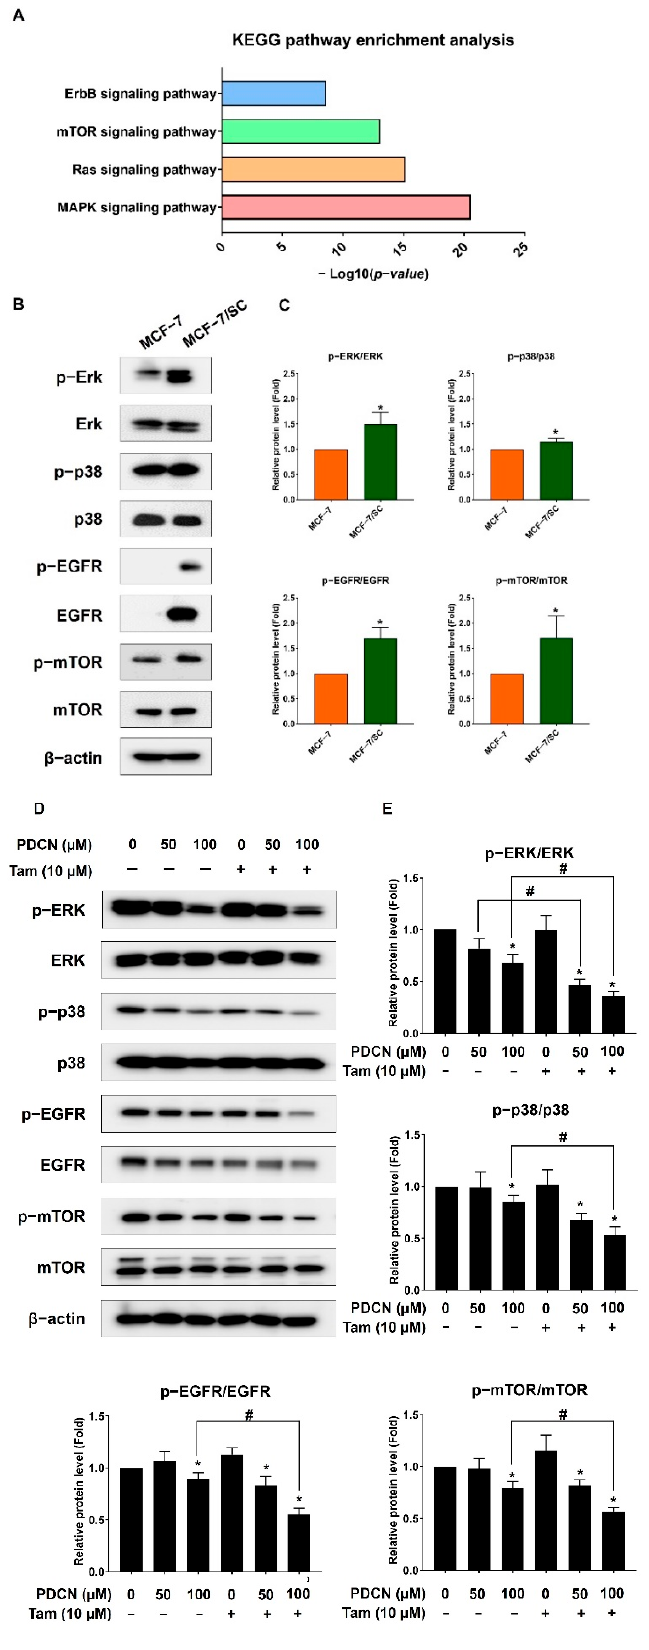
Figure 8. Pentadecanoic acid combined with tamoxifen inhibited survival − associated signaling pathways. ( A ) KEGG analysis was used to analyze the enrichment of common survival pathways in MCF − 7/SC cells compared to those in MCF − 7 cells. The levels of proteins related to ERK1/2, MAPK, EGFR, and mTOR signaling compared between MCF − 7 and MCF − 7/SC ( B , C ) cells or fol- lowing pentadecanoic acid or combined treatment for 48 h in MCF − 7/SC cells ( D,E ). β− actin was used as a loading control. The asterisk (*) indicates p < 0.05 vs. the control. The hash mark (#) indi- cates p < 0.05 when comparing the combined vs. individual treatments. Data are representative of three biologically independent experiments and values are shown in mean ± SD. 3. Discussion Heterogeneity is known to be a characteristic feature of breast cancer [35]. Therefore, the response of breast cancer to each treatment is disparate and depends mainly on the alteration of molecular expression, such as the estrogen receptor status [36–38]. Indeed, ER overexpression—a marker required for endocrine therapy response—has been ob- served in approximately two thirds of the patients with breast cancer [39]. Meanwhile, patients with ER − negative breast cancer exhibit a malignant phenotype and have poor prognosis; further, endocrine therapy does not yield viable outcomes in these patients [40]. Based on these observations, re − sensitization to endocrine therapy is a potential strat- egy for treating ER − negative breast cancer. In this study, reduced ER −α expression and significantly high tamoxifen resistance were observed in MCF − 7/SC cells compared to in the parental MCF − 7 cells. In this respect, MCF − 7/SC could be considered a suitable cell line for studies related to regulation of ER expression to overcome tamoxifen resistance in breast cancer. However, single − agent chemotherapeutic compounds have significant limitations in that they are not individually as effective, or are effective only at dose levels that are un- safe for patients [21]. Considering these challenges, combination therapy is a favorable approach for cancer treatment. Combinations of cancer therapies can be used to create a synergistic effect using more than one drug when each drug has a different target signal-